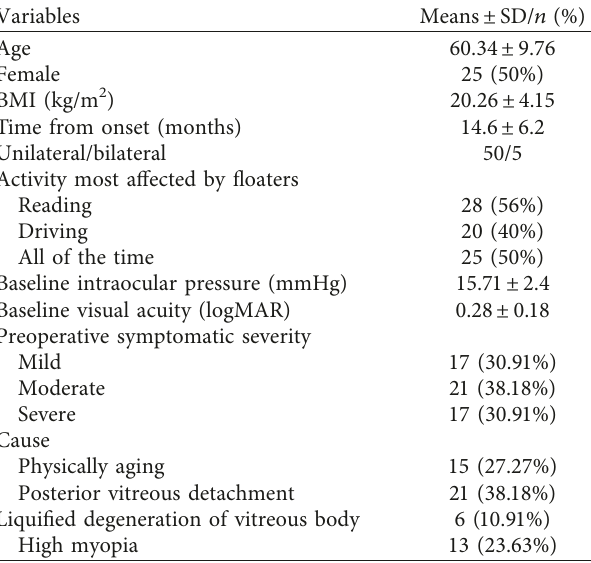
Table 1: Baseline characteristics of the included